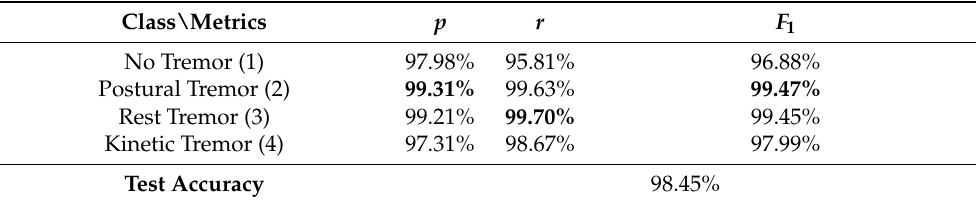
Table 6. Classification performance results computed on acceleration and gyroscope data (considering all axis).